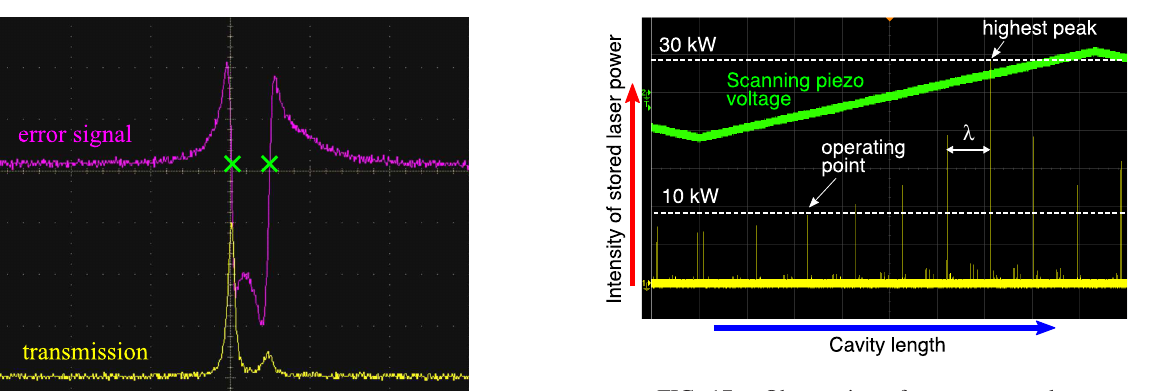
FIG. 17. Observation of resonance peaks.